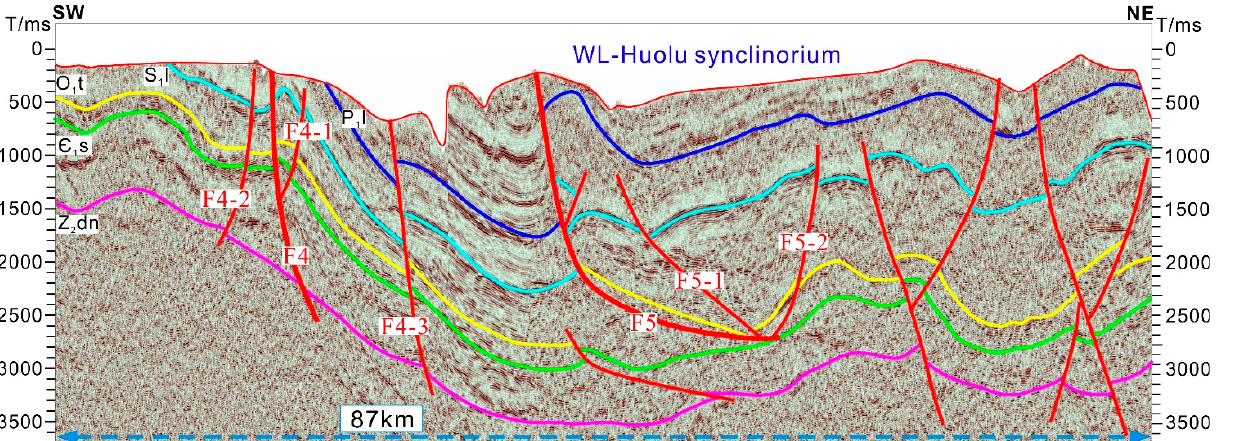
Figure 5. Seismic interpretation profile of L2. (F6: Pengshui–Jianshin fault).